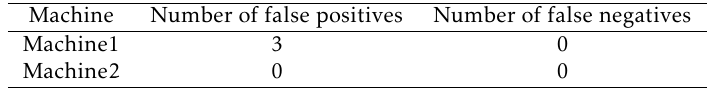
Table 5. False positives and false negatives caused by local detection mechanism